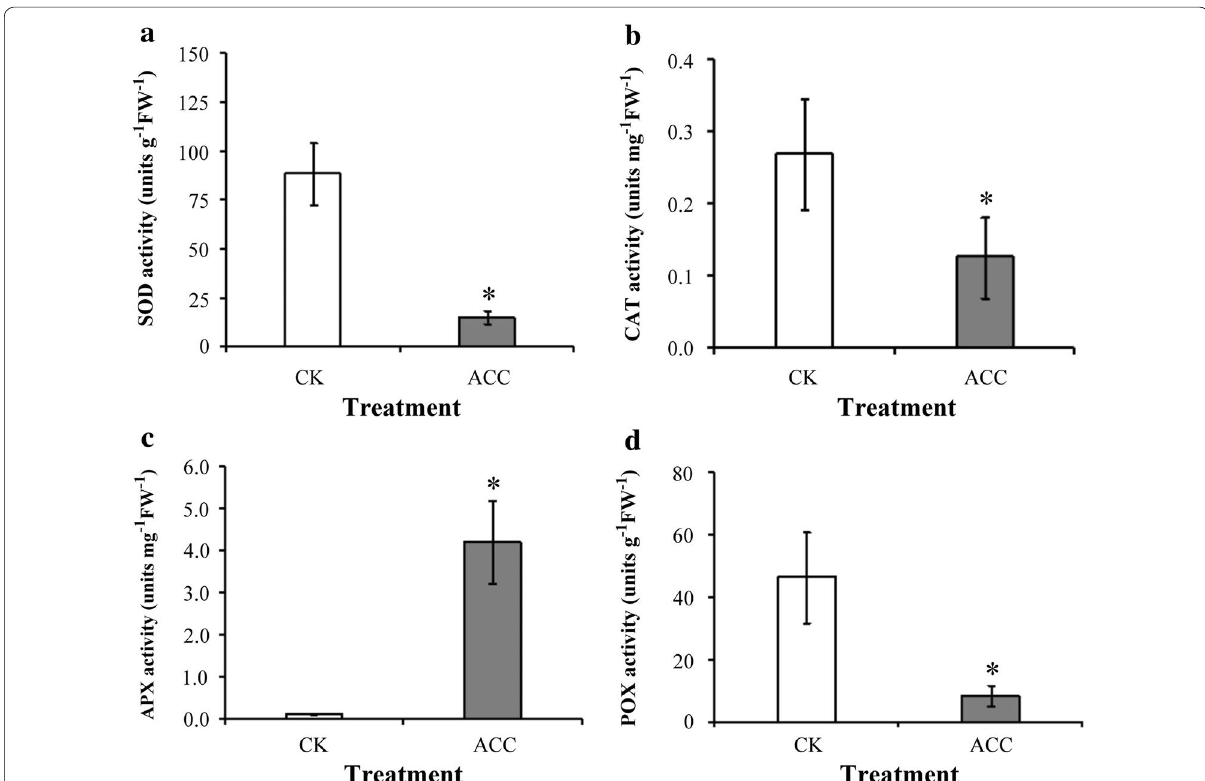
Fig. 3 CAT, APX, SOD, and POX activity in tea seedlings on modulation of ethylene signaling. Enzyme activity was detected from the detached tea seedling samples with one tip and two leaves after treatment with the control (CK) or 100 μM ACC for 5 days.CAT, APX, SOD, and total POX activity was determined. Data points are mean SD of five biologically independent experiments. Asterisks indicate significant differences from the control ± sample (P < 0.05; Student’s t test)